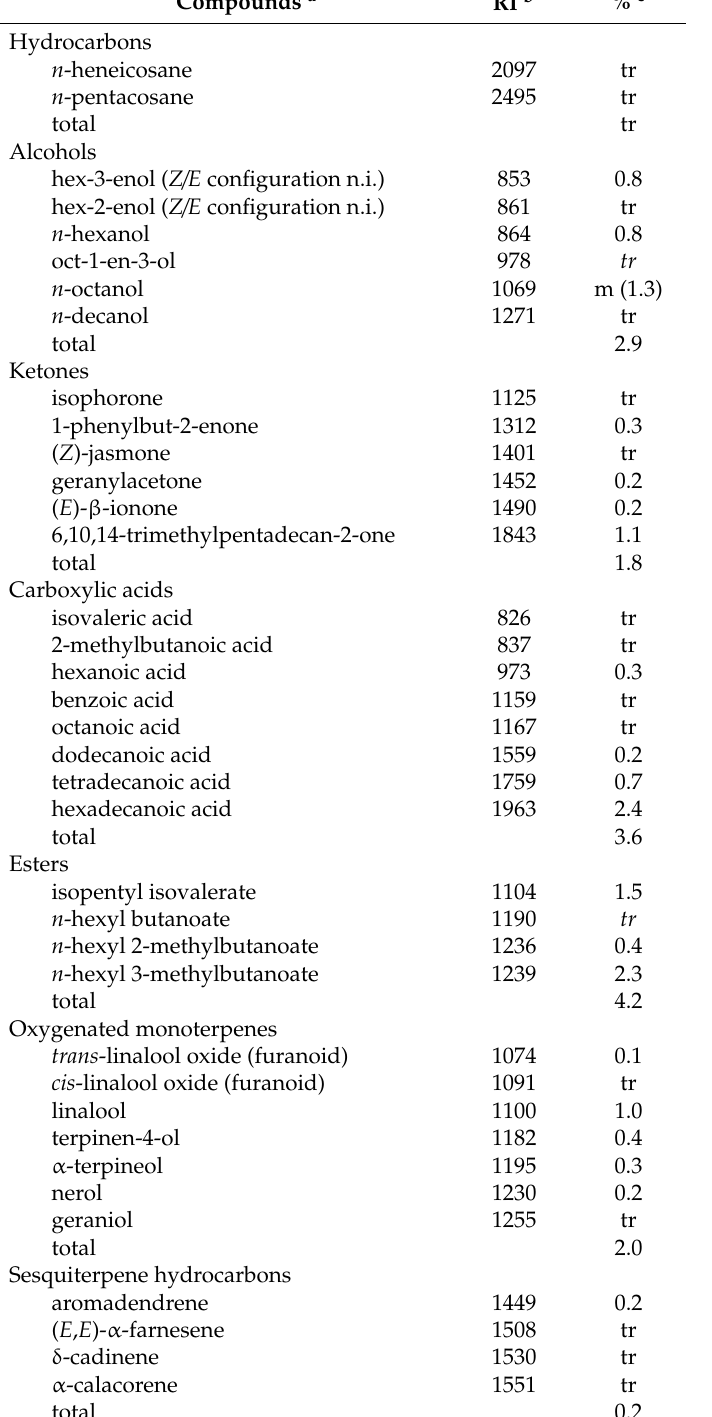
Table 1. Chemical composition of the essential oil of leaves from Dodonea viscosa. Compounds